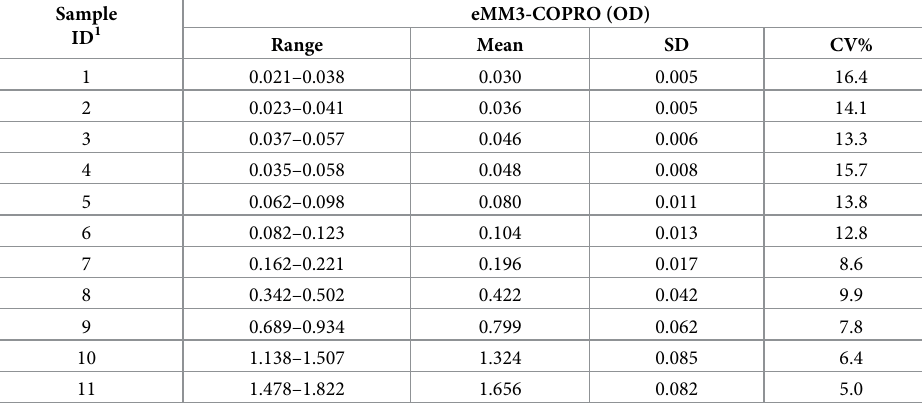
Table 2. Precision profile of the eMM3-COPRO